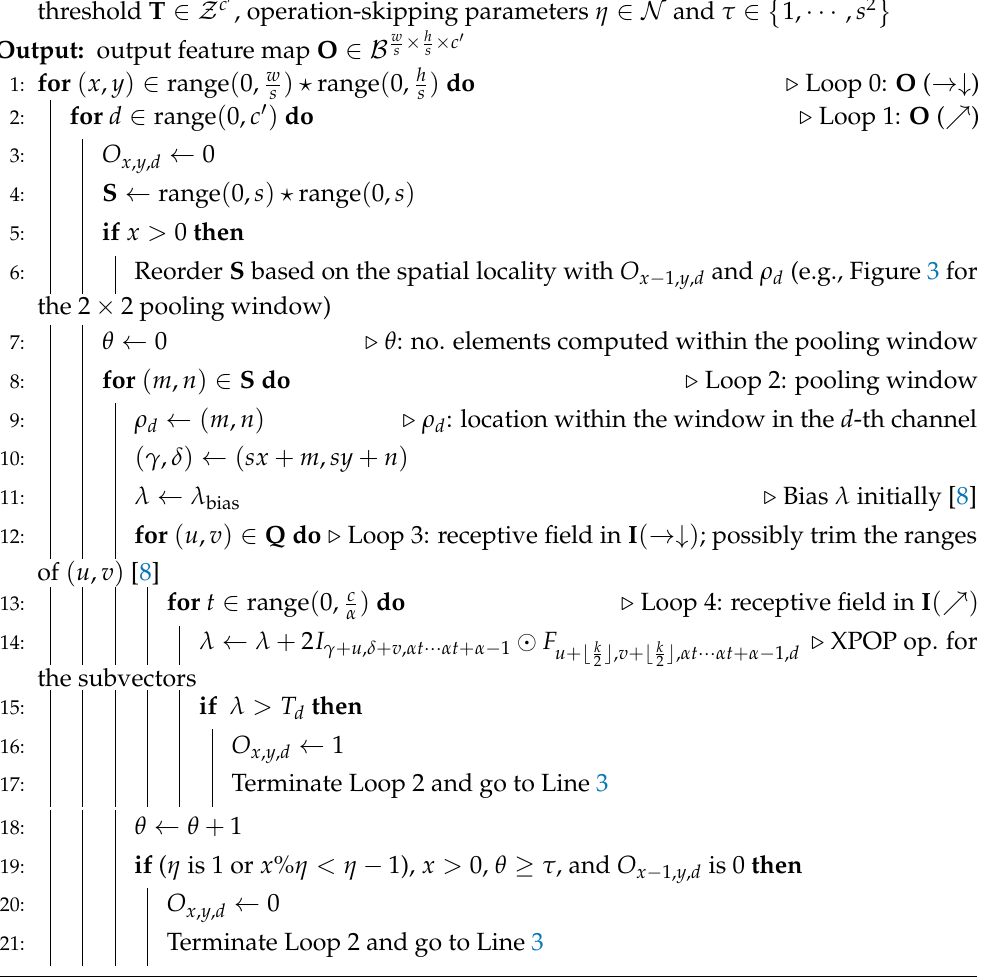
Algorithm 1 Block processing flow in TORRES, where B (cid:44) { 0, 1 } , and N and Z are the natural and integer number sets, respectively